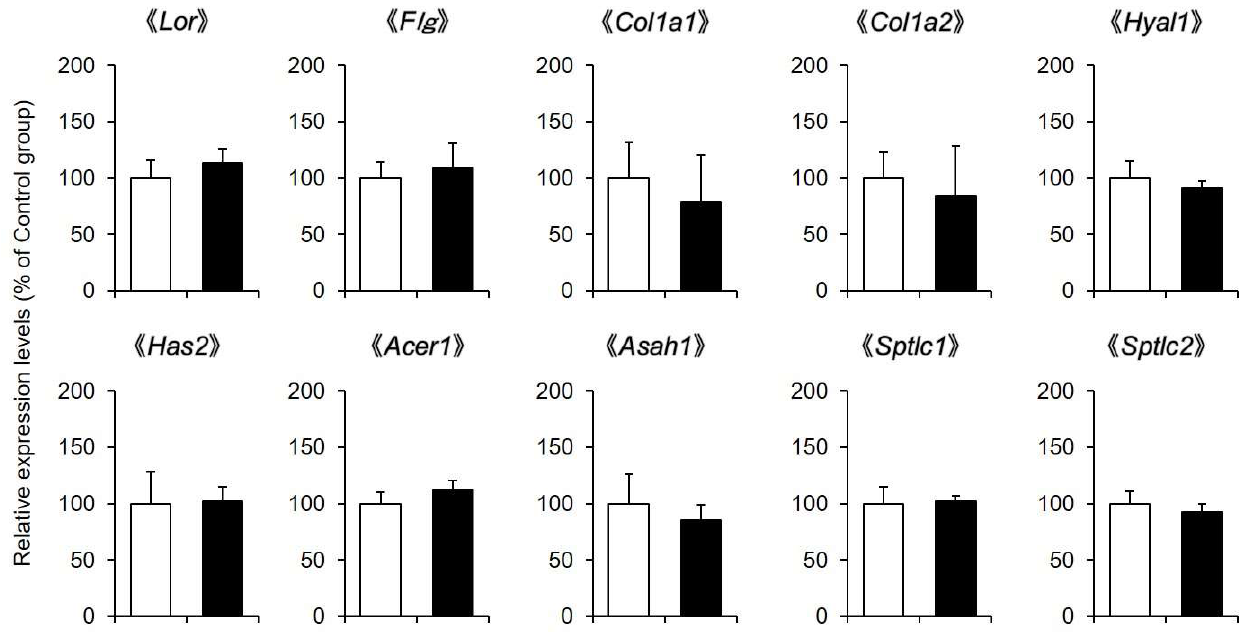
Figure 3. Expression levels of skin moisturizing factor-related genes. A 1% CBD solution was applied to the back skin of mice for 14 days (black). A solvent was applied to the control group (white). After the treatment, the mRNA expression levels of Lor , Flg , Col1a1 , Col1a2 , Hyal1 , Has2 , Acer1 , Asah1 , Sptlc1 , and Sptlc2 in the skin were analyzed by real-time RT-PCR ( n = 6, means ± SD).